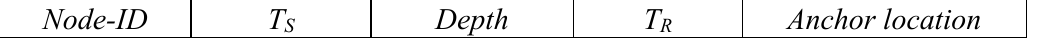
Figure 5. Completed message by